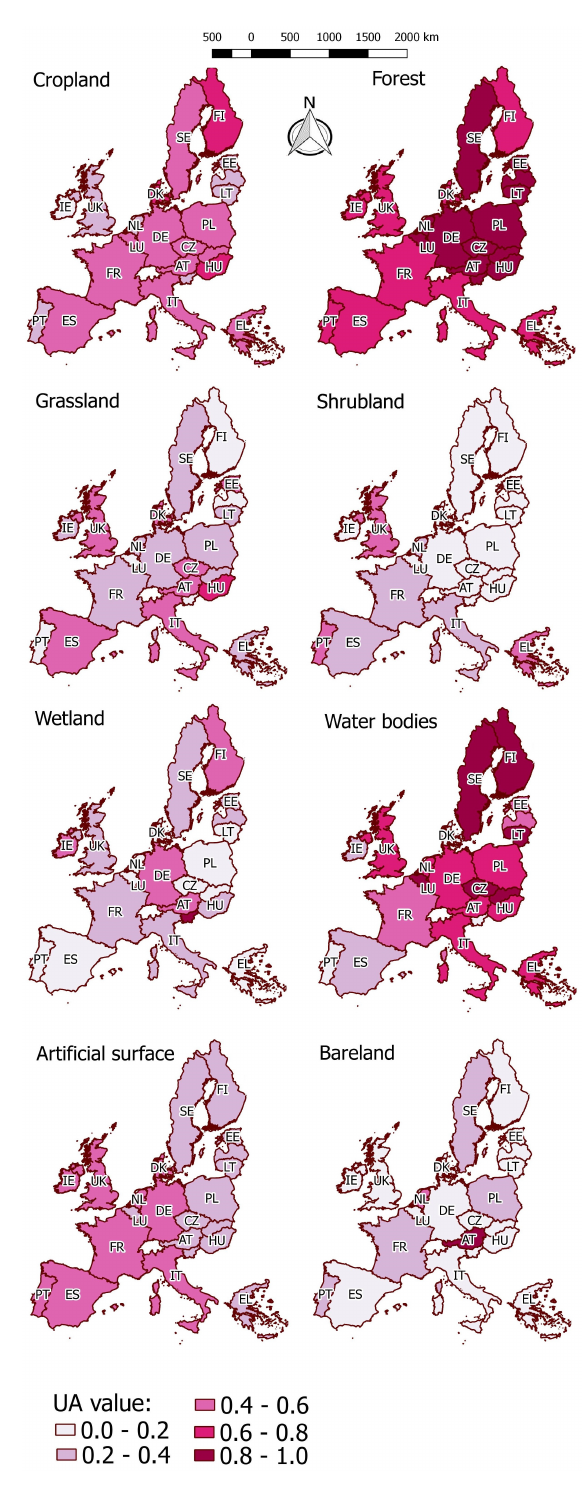
Figure 1. Producer’s accuracy for each country